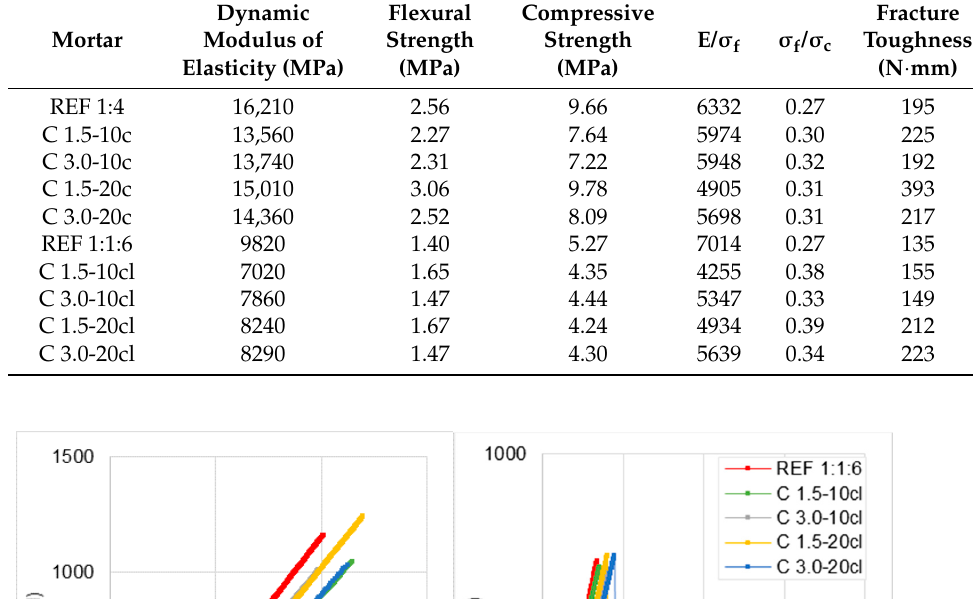
Table 4. Parameters related to cracking susceptibility of the mortars tested.